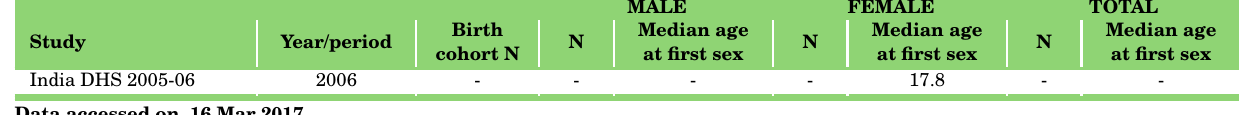
Table 41: Median age at first sex in